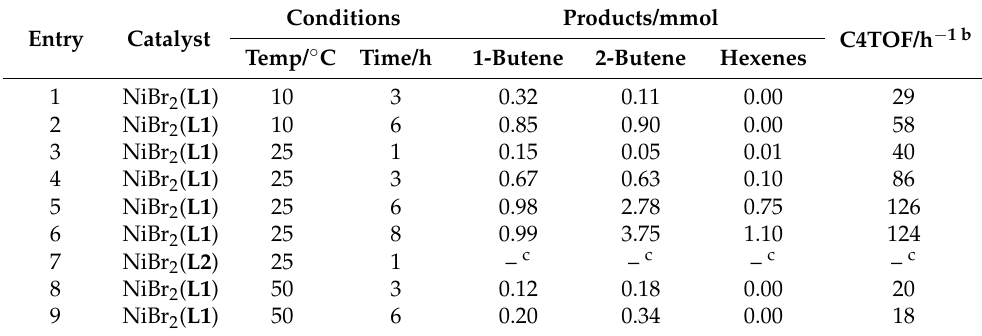
Table 1. Ethylene oligomerization catalyzed by NiBr 2 ( L1 ) a .